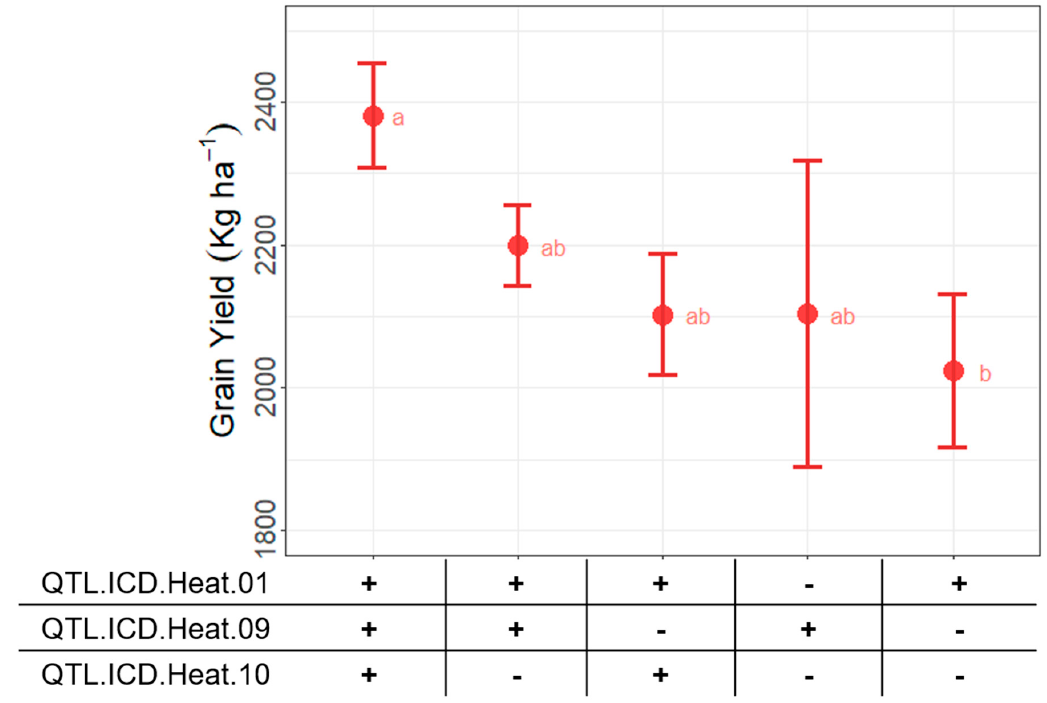
Figure 5. Effect of different allele combinations of the significant loci on yield performance of 208 accessions tested under heat stressed conditions along the Senegal River. The circle indicates the average of each class over 2 years, and the whiskers show the standard error of the mean. The accessions were divided into five clusters based on their haplotype for three major QTLs: “+” mark the positive and “-” the wild-type alleles. Letters (a, b, ab) indicate significant differences between the clusters.